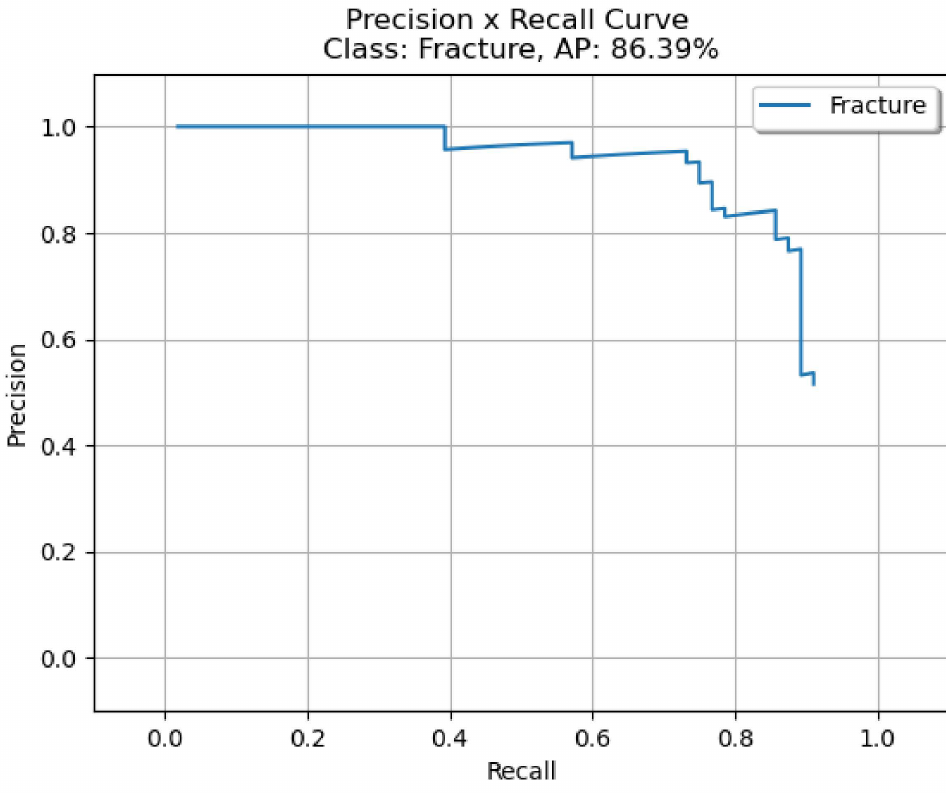
Figure 23. Precision-recall curve of WFD-C (best score of ensemble